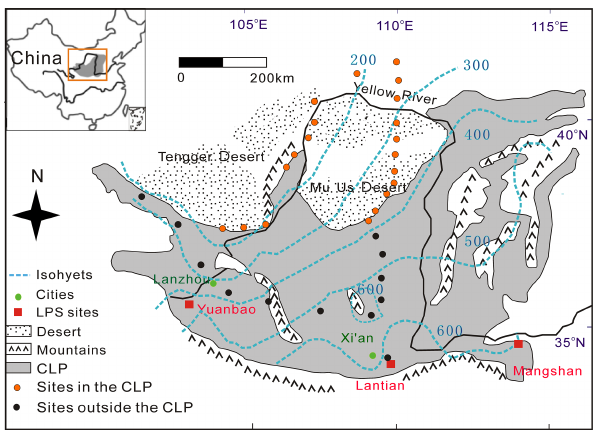
Figure 1. Sketch map of the CLP and its surroundings showing the location of sampling sites for surface soils collected in this study (modified from Xia et al., 2012). The sites of three LPS sections with published bGDGT data (Yuanbao, Lantian and Mangshan) are also shown. The relative position of the study region in China is indicated in the upper left.